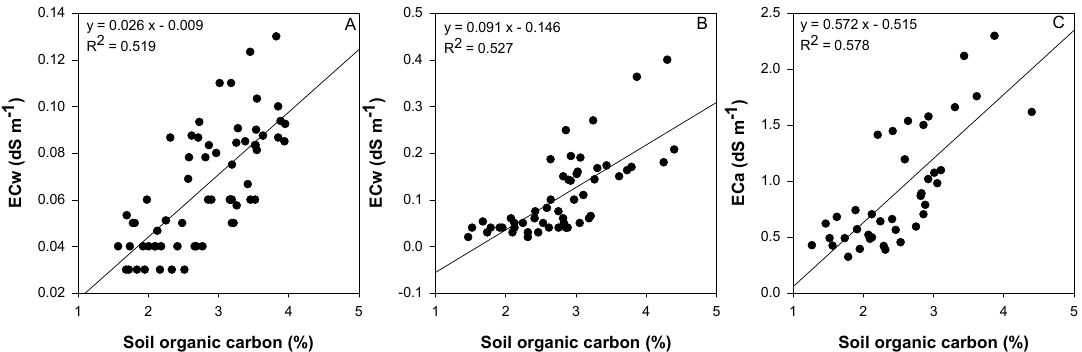
Figure 9. Relationship between soil organic carbon and bulk electrical conductivity, EC a ( A ) at 0–10 cm depth, electrical conductivity of soil solution, EC w at 0–10 cm ( B ) and 10–20 cm ( C ) soil depths in podzolic soils under various nutrient management practices.